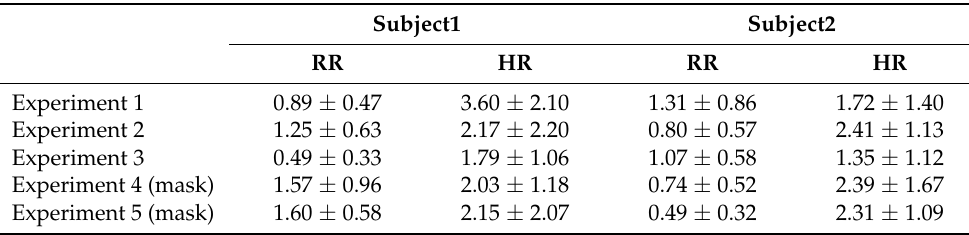
Table 4. Mean and standard deviation of the absolute error of two-subjects RR and HR estimations (RR unit: breaths/min, HR unit: